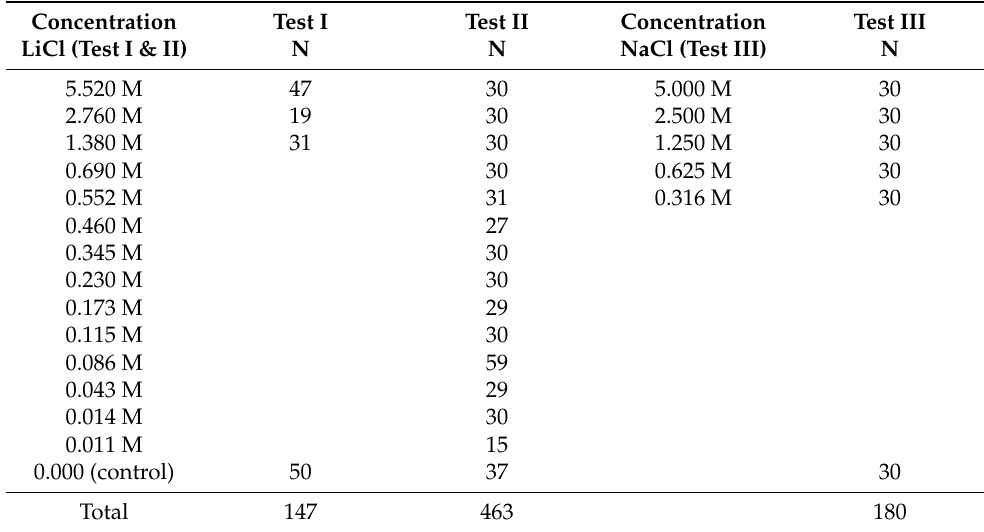
Table 1. The number of dog ticks tested ( N ) for the effect of lithium chloride (LiCl) in Tests I and II, and for the effect of sodium chloride (NaCl) in Test